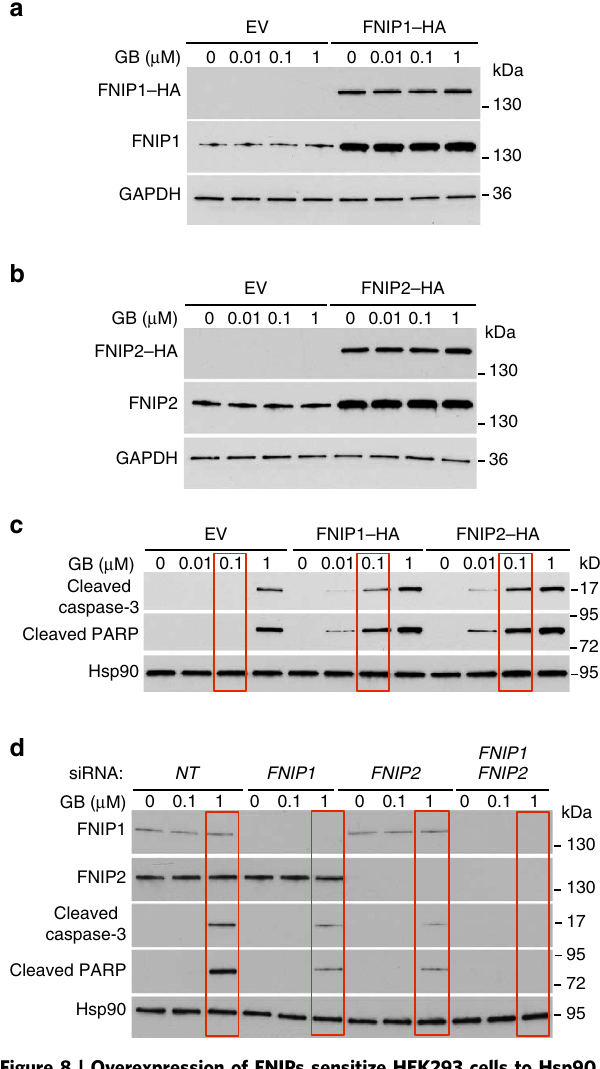
Figure 8 | Overexpression of FNIPs sensitize HEK293 cells to Hsp90 inhibitor. ( a ) HEK293 cells were transiently transfected with HA–FNIP1 or empty vector (EV), ( b ) or HA–FNIP2 or empty vector (EV), and treated with indicated amounts of GB. ( c ) Induction of apoptotic markers in lysates from a and b were shown by immunoblotting using anti-cleaved caspase-3 and cleaved PARP antibodies. ( d ) FNIP1 , FNIP2 or both were silenced by siRNA in HEK293 cells and then treated with indicated amounts of GB. Apoptotic markers were examined by immunoblotting using anti-cleaved caspase-3 and cleaved PARP